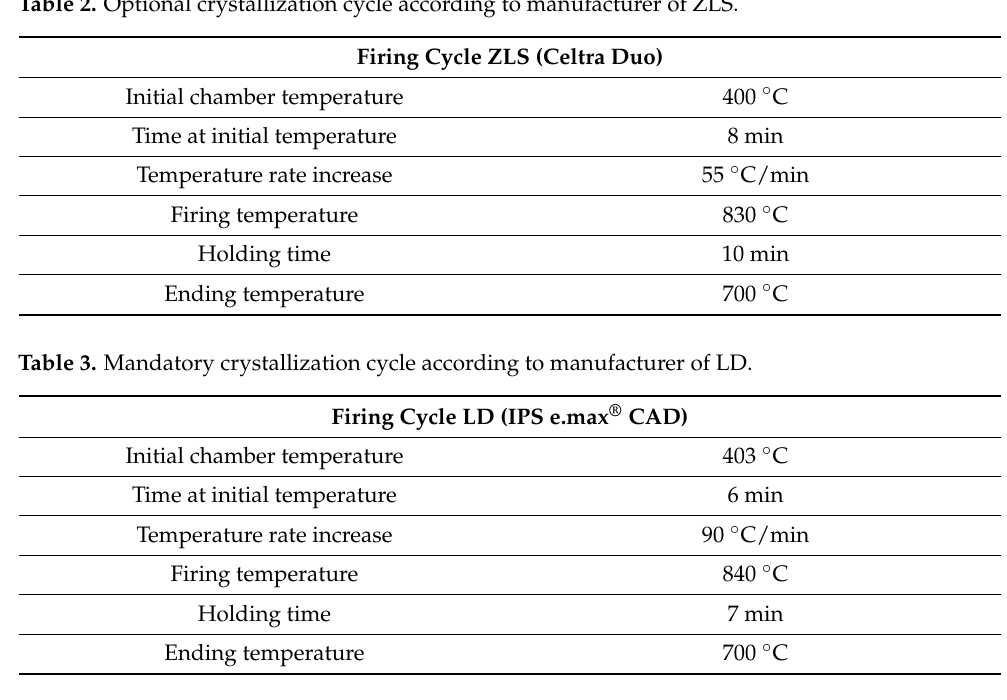
Figure 1. Flowchart of groups distribution according to restorative material (ZLS and LD), crystal- lization firing, and aging. Table 2. Optional crystallization cycle according to manufacturer of ZLS.